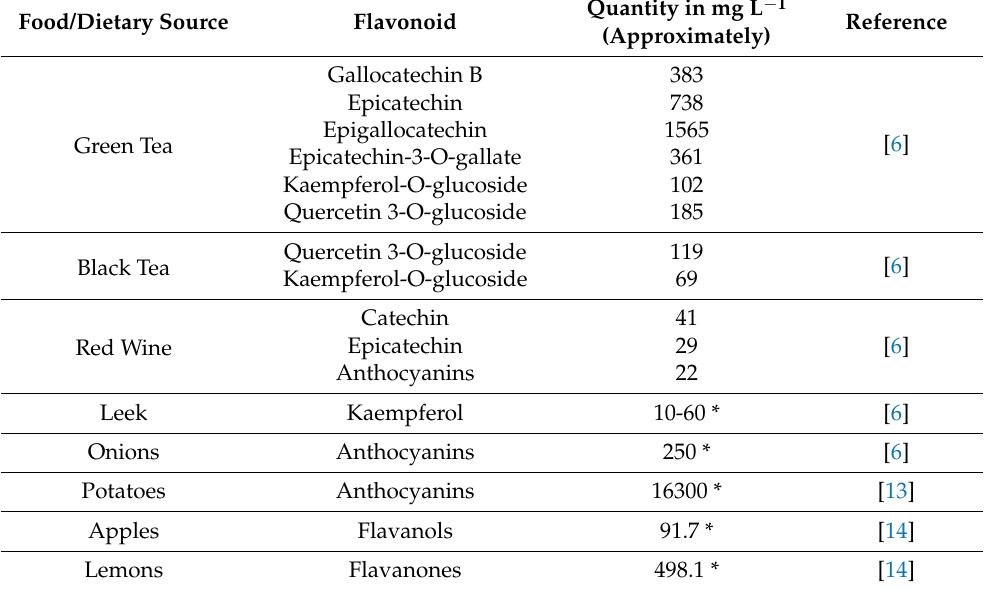
Table 2. Some of the dietary sources of